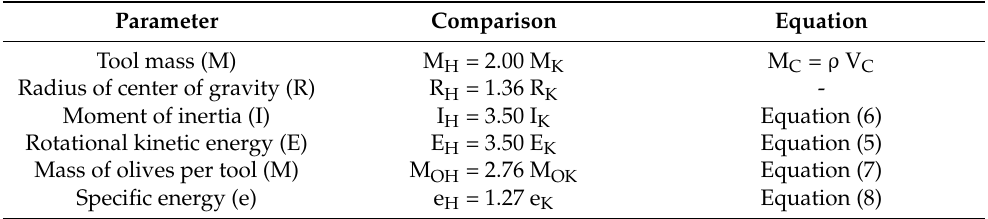
Table 2. Comparison of the main parameters of rotor